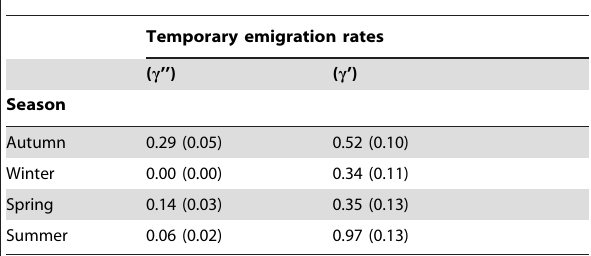
Table 7. Seasonal temporary emigration rates for the best fitting Markovian model using the overall dataset that included all juvenile and adult dolphins